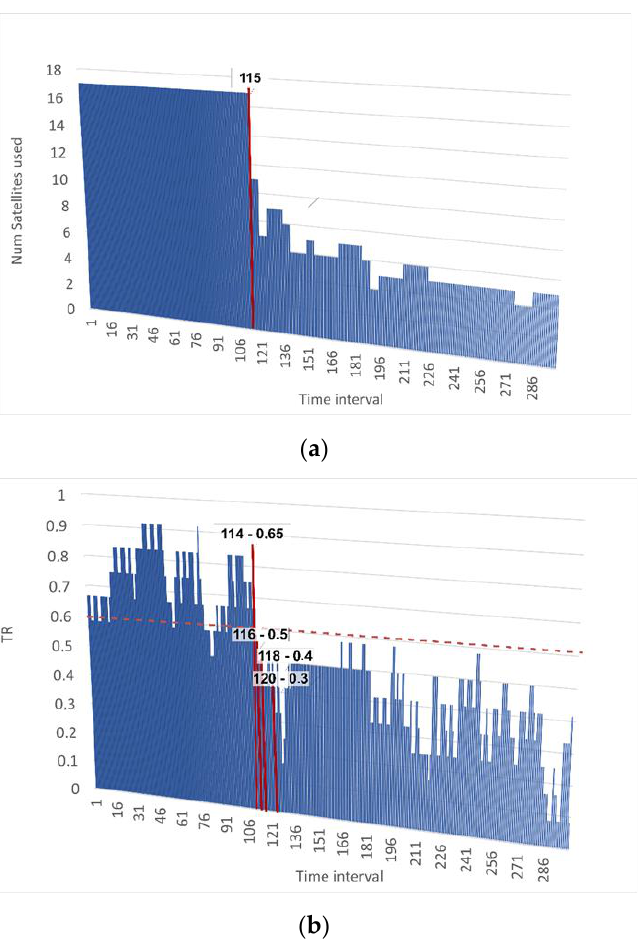
Figure 14. Estimating time of attack detection using state detection: ( a ) number of satellites used and ( b ) level of trust (TR) in the process being executed.